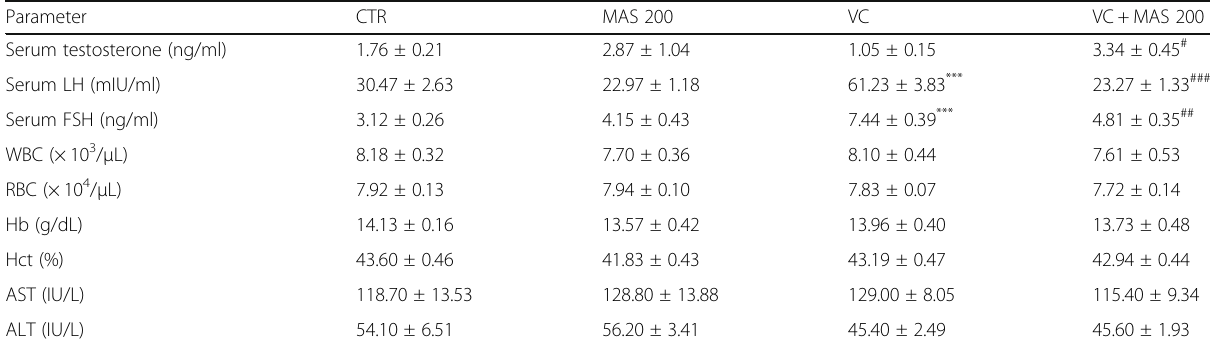
Table 4 Effect of MAS 200 on biomarkers of blood and serum hormone concentration in varicocele-induced male SD rats Parameter CTR MAS 200 VC VC + MAS 200 Serum testosterone (ng/ml) 1.76 ± 0.21